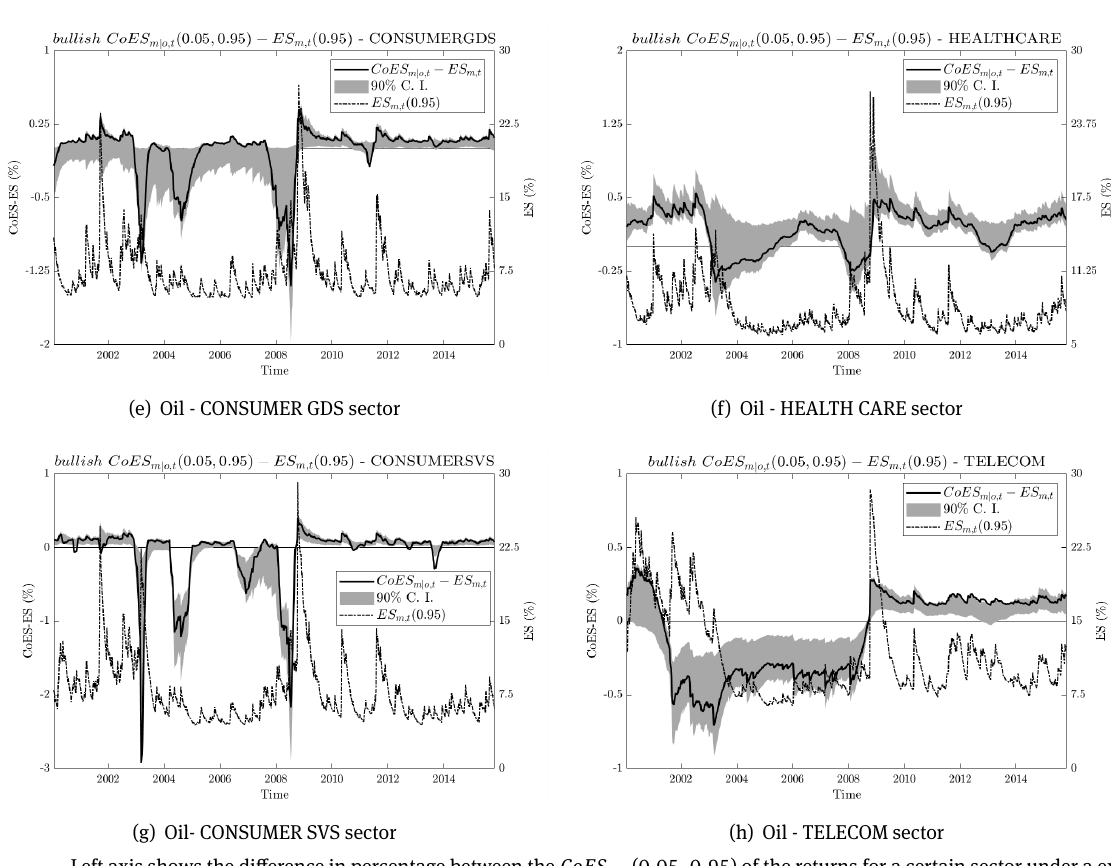
Figure 21b: CoES m | o , t (0.05, 0.95) for a certain sector given a bearish scenario for oil